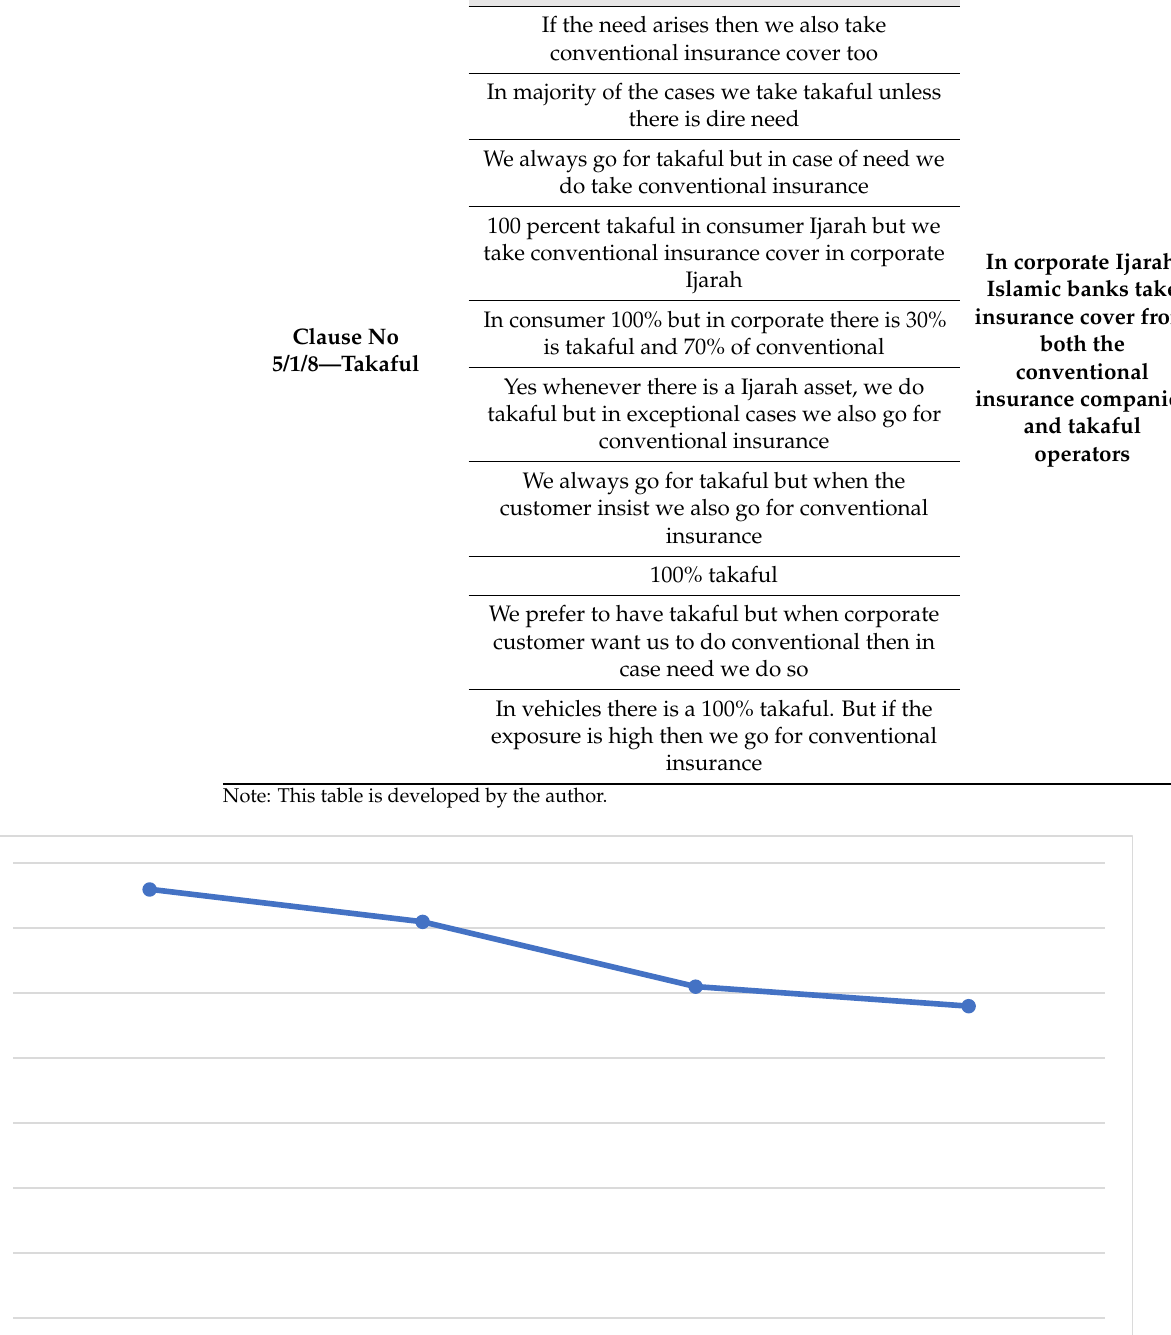
Table A5. Clause 5/1/8—takaful.